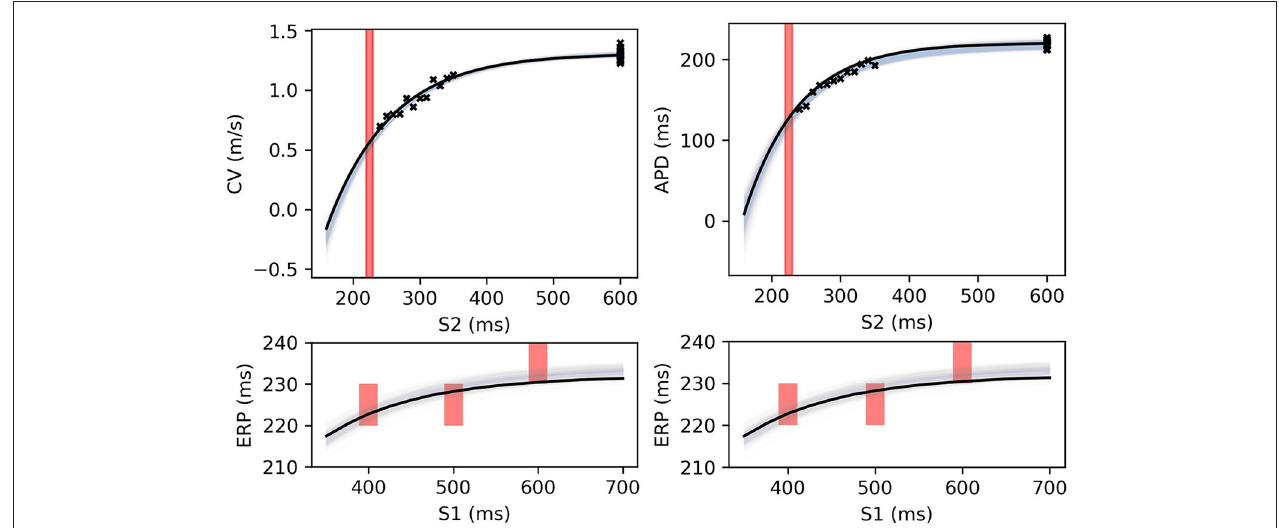
FIGURE 12 | RCE predictions, shown as lightly shaded regions representing 95% confidence intervals, for 100 parameter samples from the posterior distribution given the same measurements shown in Figure 8 (black crosses are noisy S2 restitution data, red bars are observed ERP intervals). MCMC utilized CV(S2), APD(S2), and ERP(S1) data simultaneously, unlike in Figures 8 , 9 .